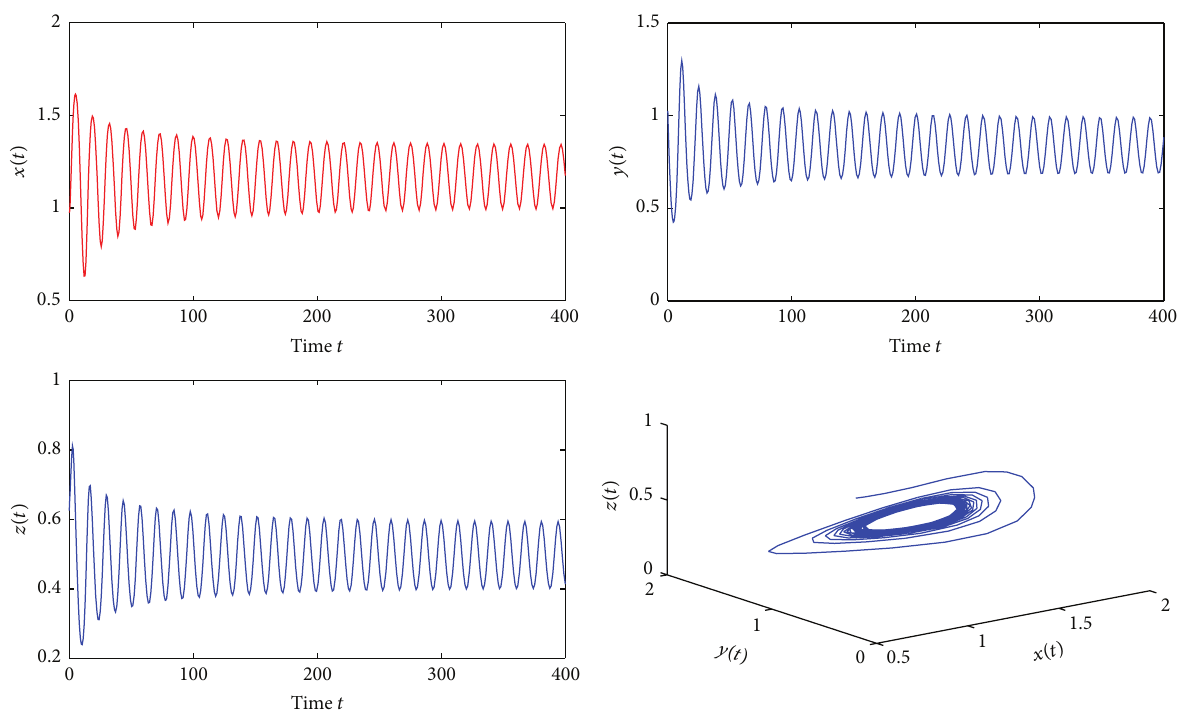
Figure 4: 𝐸 ∗ is unstable for 𝜏 2 = 1.96 > 𝜏 20 = 1.7990 with initial values 0.975, 1.025, and